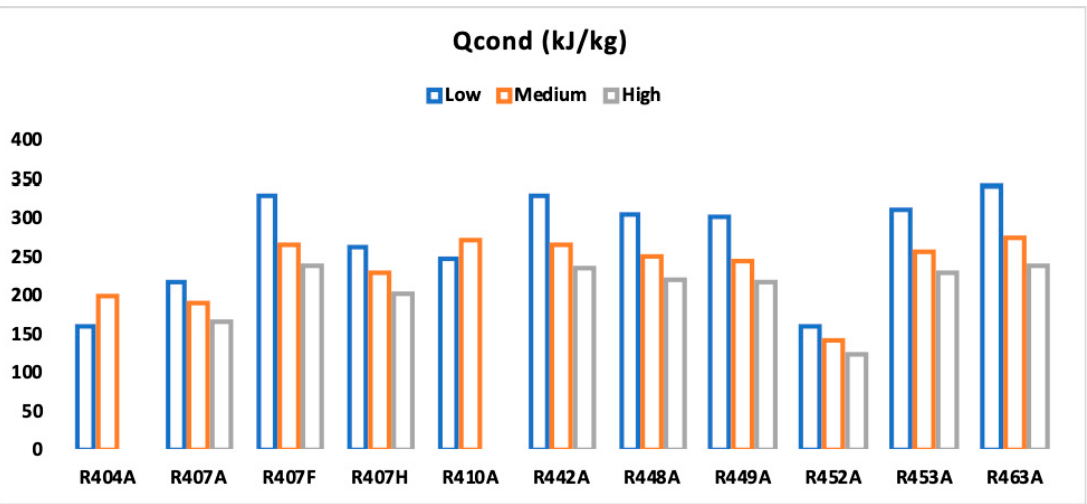
Figure 13. Heat rejection of all refrigerants.